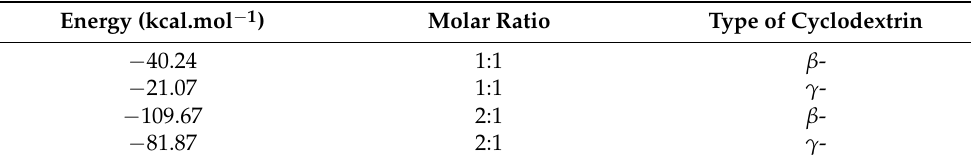
Table 3. Computed average values of intermolecular interaction